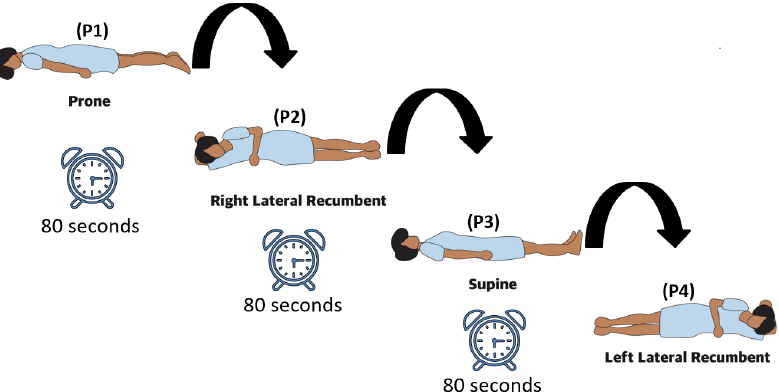
Figure 2. We have performed the experiment in all four regular sleeping positions. The subject switched position after every 80 s.